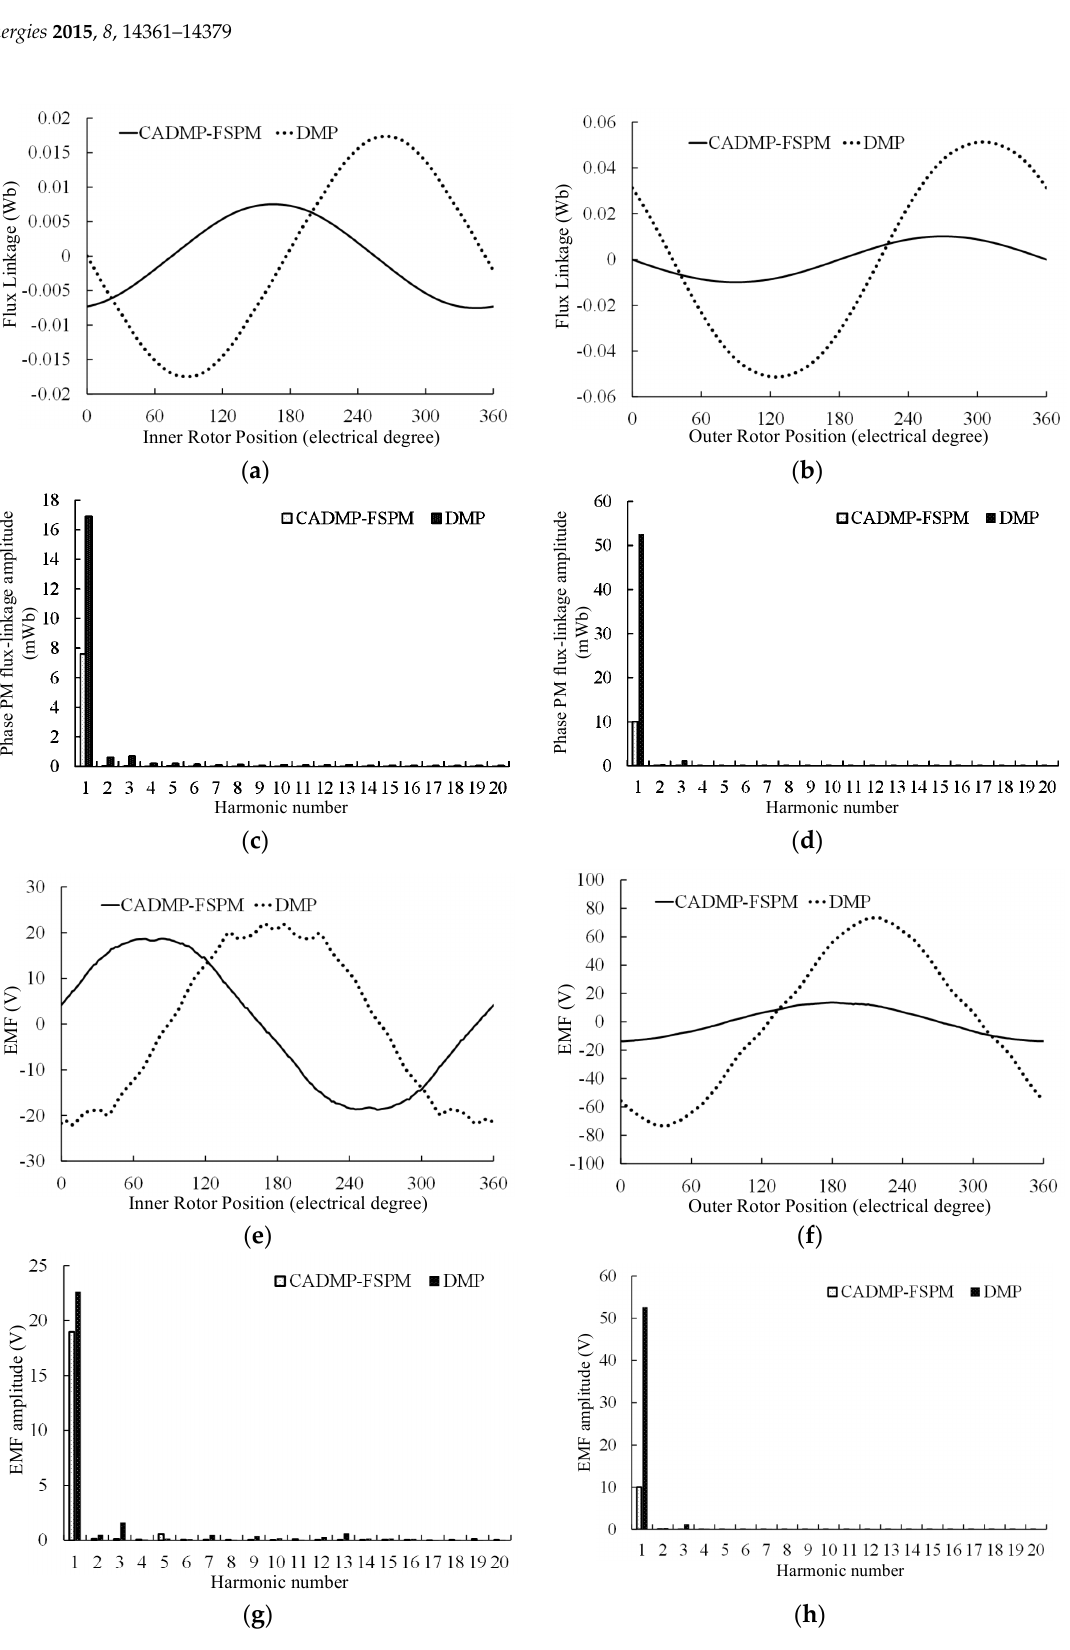
( d ) Figure 6. Open ‐ circuit air gap flux density distributions of the two machines due to magnets only. ( a ) Inner FSPM machine of the CADMP ‐ FSPM machine; ( b ) Inner machine of the DMP machine; ( c ) Outer FSPM machine of the CADMP ‐ FSPM machine; ( d ) Outer machine of the DMP machine. The corresponding phase electro ‐ motive force (EMF) per turn of the CADMP ‐ FSPM machine and the DMP machine can be calculated by Equation (6), where, ω r is the mechanical rotation speed of the machine, θ r is the mechanical degree of the rotor and P r is the electromagnetic pole pair number. The phase EMF per turn waveforms at 2400 r/min of the two inner machines are shown in Figure 7e;